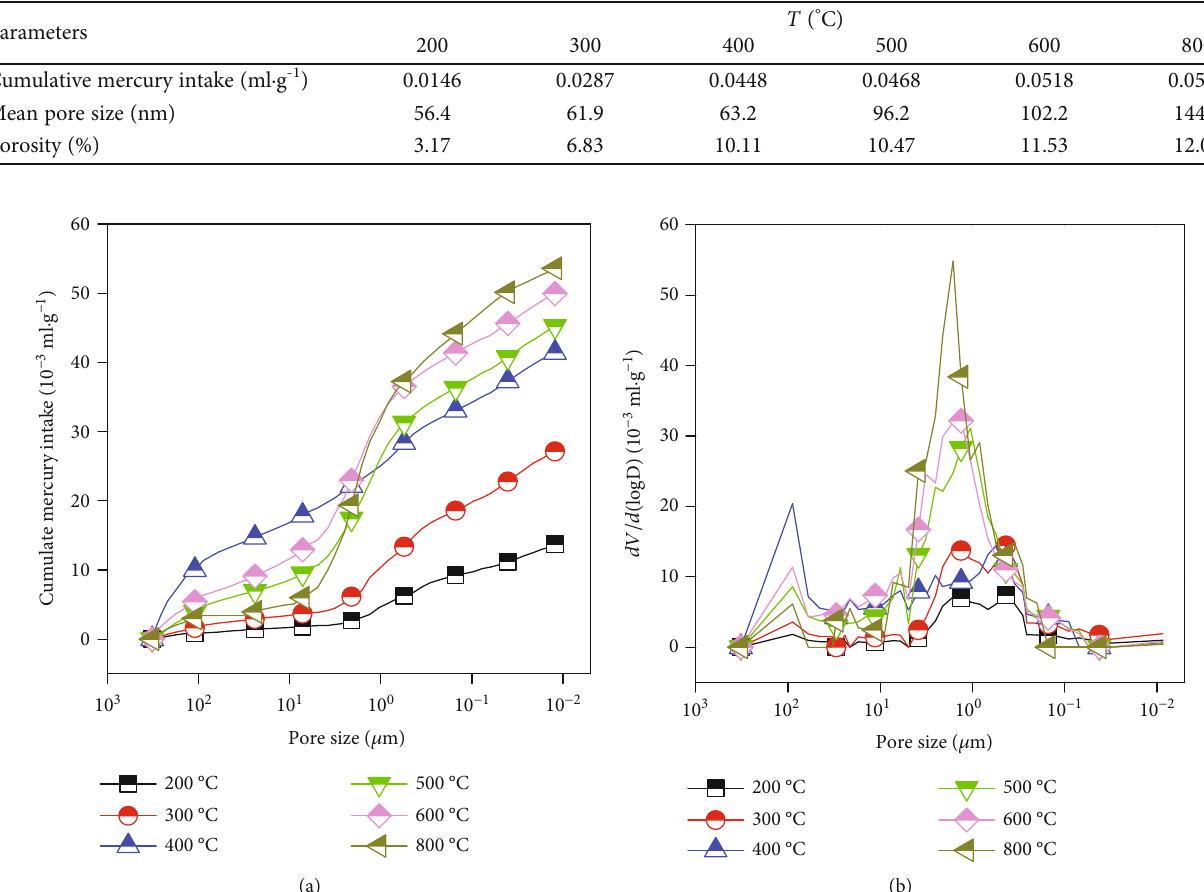
Figure 5: Pore structure of heat-treated red sandstone. (a) The relationship between the cumulative mercury intake of red sandstone under di ff erent pore sizes. (b) The distribution of pore